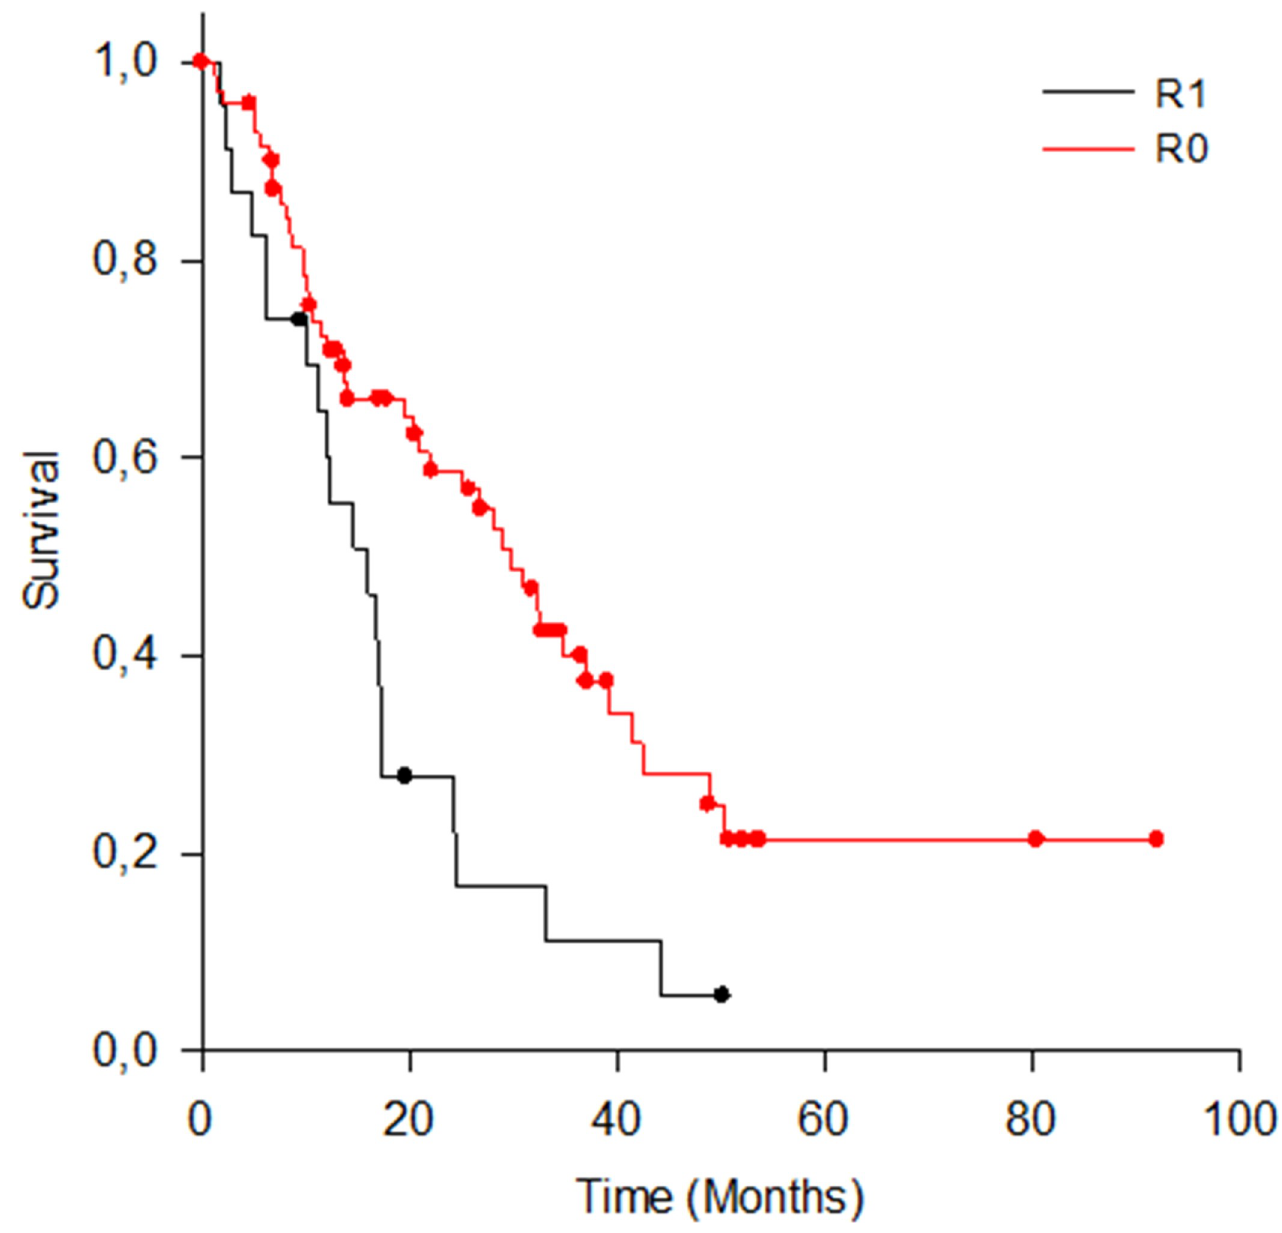
Fig 4. OS for R1 and R0